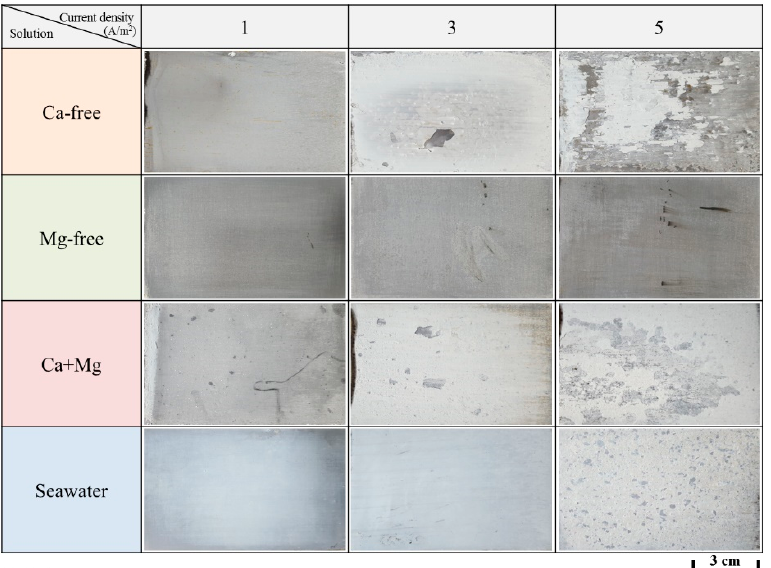
Figure 2. Photographs of calcareous deposit films according to the current density and solution.